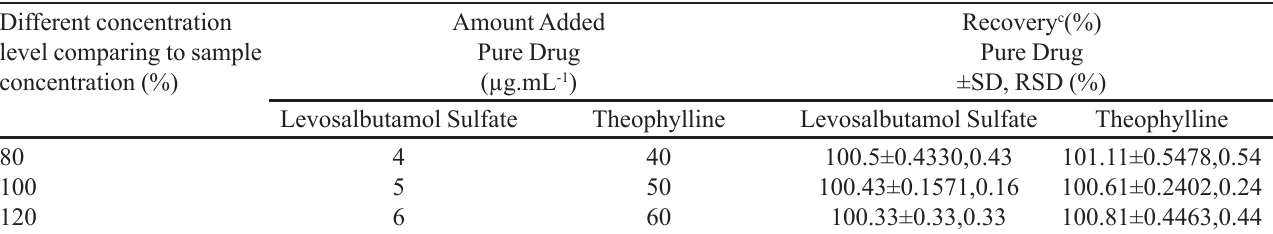
TABLE III - Accuracy of the method Different